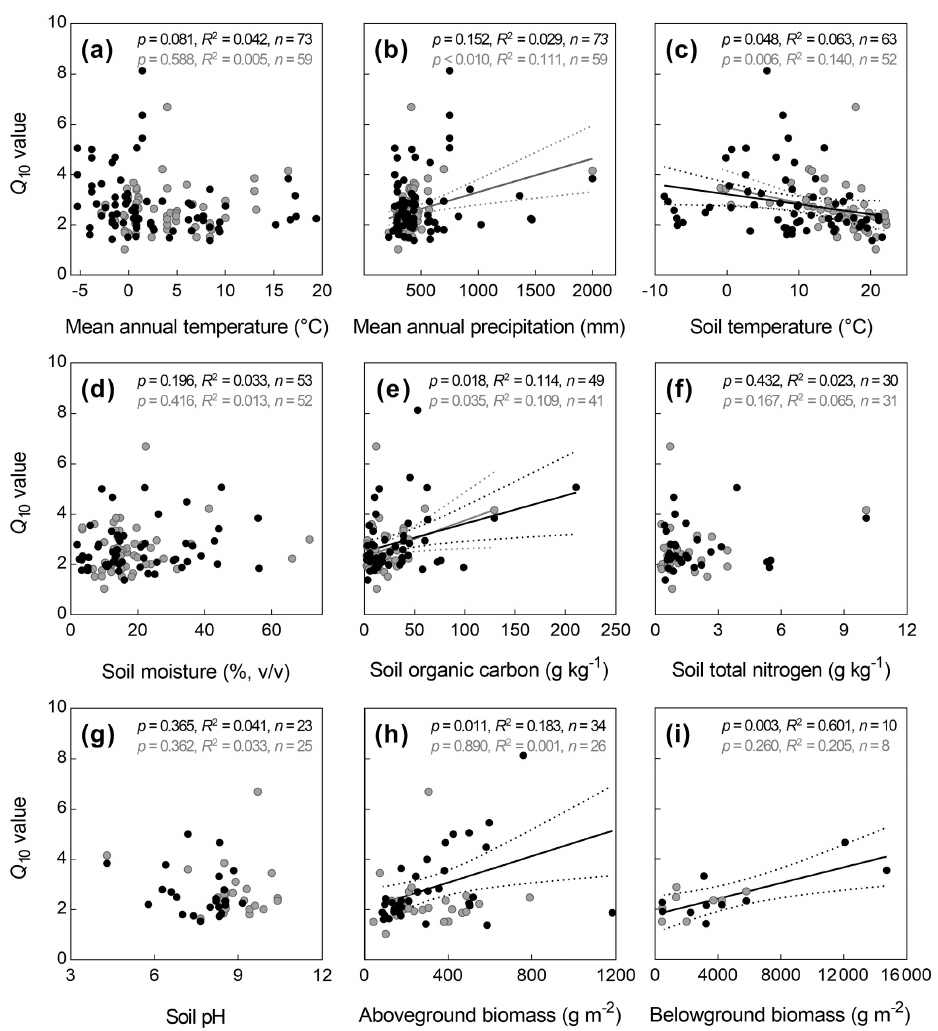
Figure 5. Relationships of temperature sensitivity of soil respiration ( Q 10 ) with abiotic and biotic factors. The black and gray points represent Q 10 derived by soil temperature at depths of 5 and 10cm, respectively, and the black and gray lines represent their corresponding relationships with environmental factors. When the p value was greater than 0.05, the regression lines were not